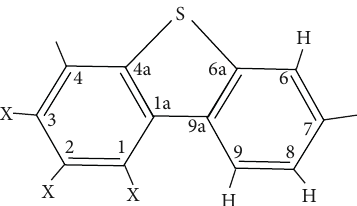
Figure 1: Scheme of the studied molecules in the series of molecules {𝑥 ,4,7-TMDBT, (𝑥 = 1,2, 3)} : X(H)–C C 3 < represent 4,7-DMDBT; X(CH 3 )–C 1 < , X(H)–C 2 < , and X(H)– C 3 < represent 1,4,7-TMDBT; X(H)–C 1 < , X(CH 3 )–C 2 < , and X(H)– C 3 < represent 2,4,7-TMDBT; X(H)–C 1 < , X(H)–C 2 < , and X(CH 3 )– C 3 < represent